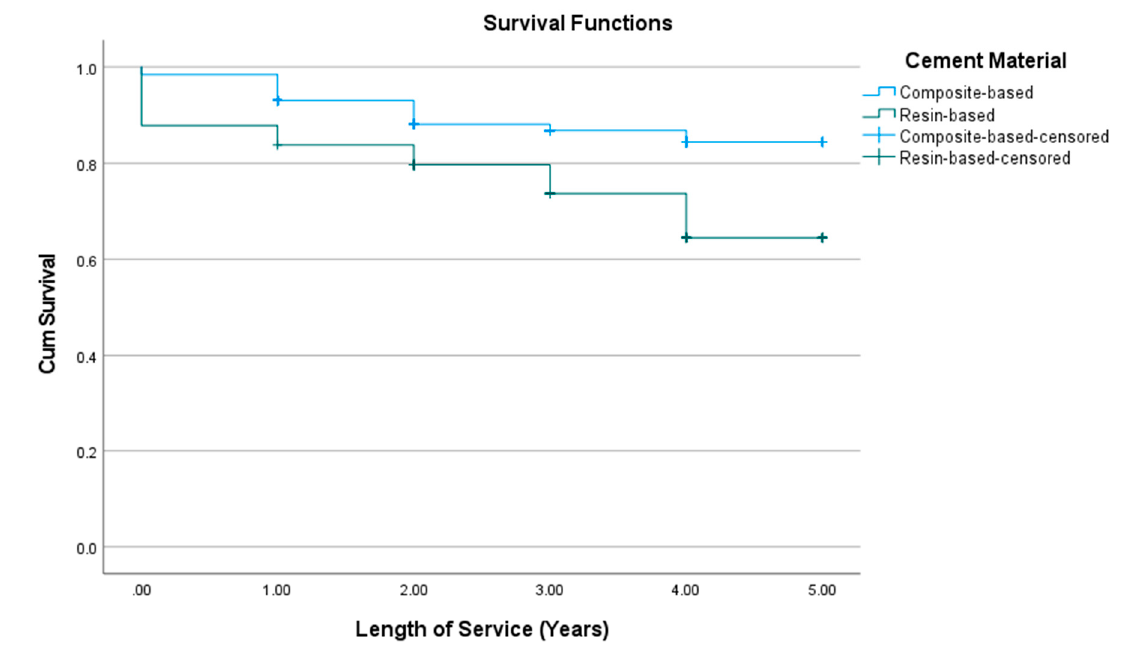
Figure 5. Kaplan-Meier survival curve of composite restorations stratified by cement material, Palacky University Hospital, 2014–2018 ( n = 469). CumSurvival = cumulative survival. The cements with high viscosity had significantly ( χ 2 = 12.522; Sig. < 0.001) higher survival (4.64 ± 0.07) than those with low viscosity (4.14 ± 0.11) (Figure 6).